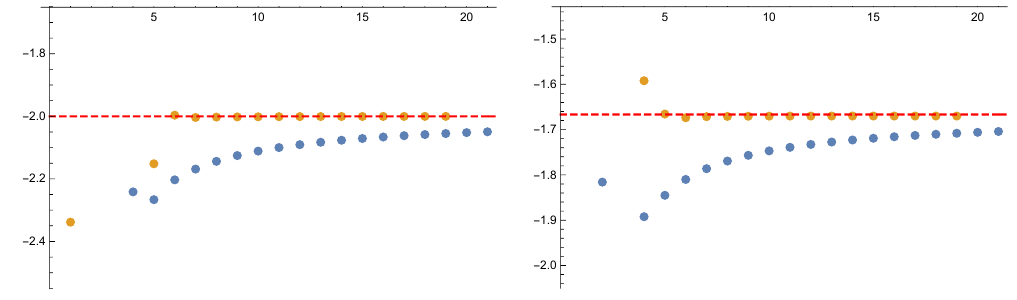
Figure 8 . The (cid:12)gure in the left (respectively, right) shows the sequence (3.29) and its second Richardson transform for the O( N ) GN model, where N = 4 and N = 5, respectively. The horizontal dashed line is the expected value